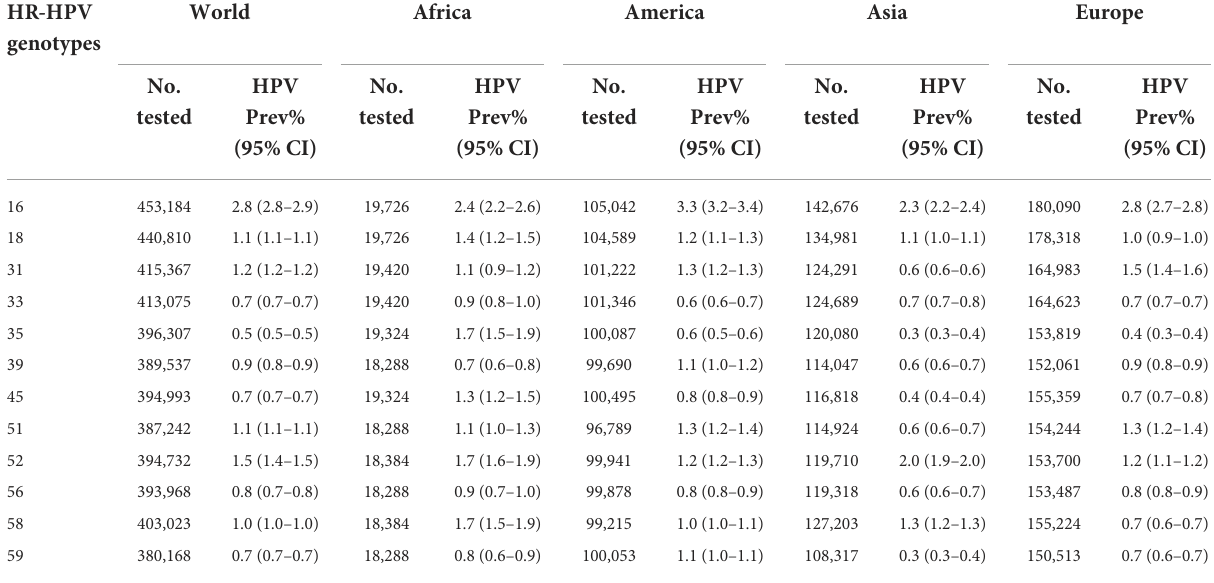
TABLE 1 Overall prevalence of most oncogenic